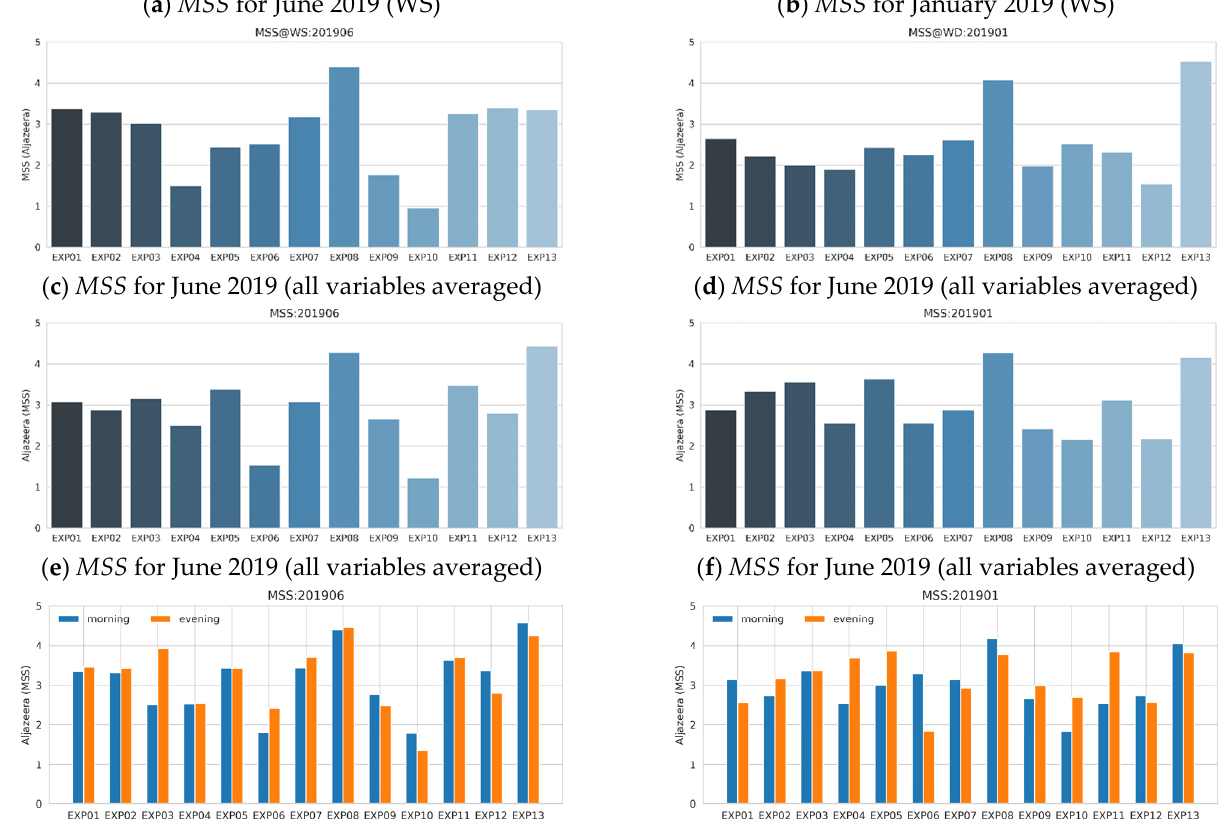
Figure 15. Model Skill Score ( MSS ) at Aljazeera calculated for June and January 2019.